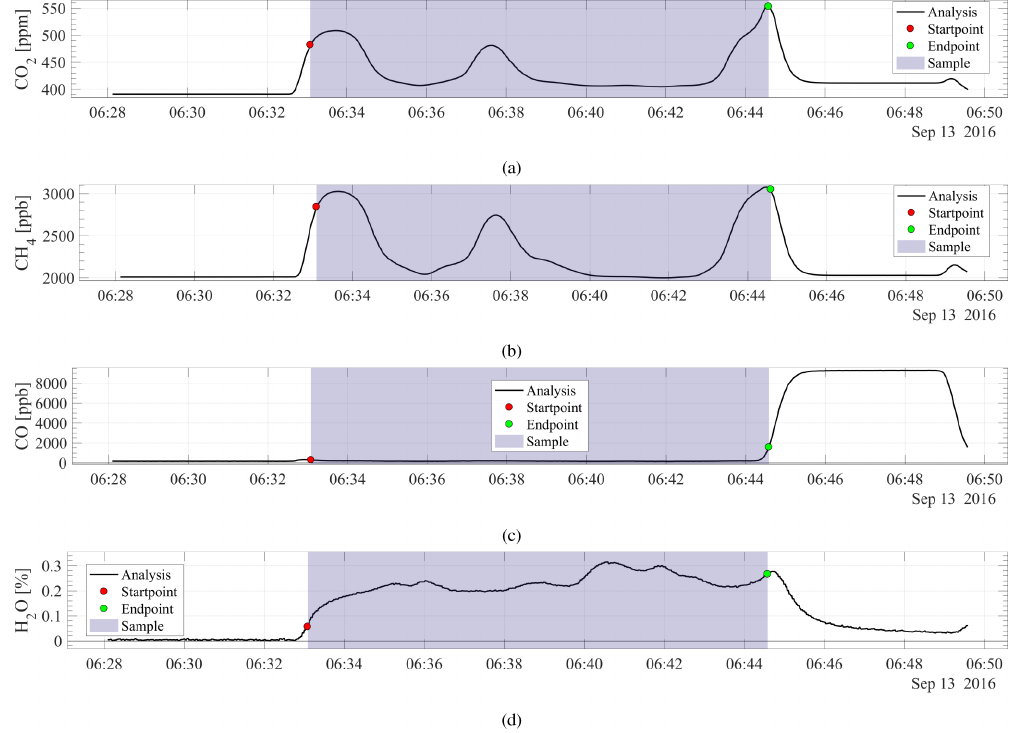
Figure 5. The analysis of CO 2 (a) , CH 4 (b) , CO (c) , and H 2 O (d) for the second flight on 13 September 2016. The red and green dots indicate the start and end point of the sample,